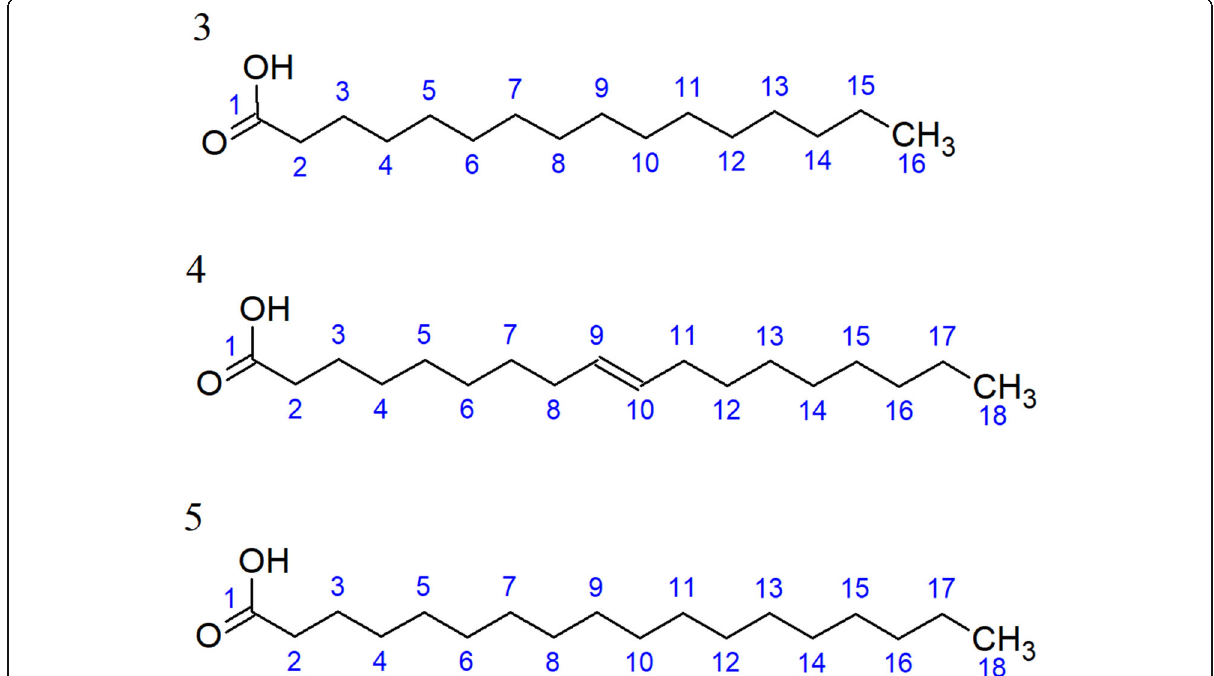
Fig. 5 Structure of hexadecanoic acid/palmitic acid (3), (9Z)-Octadec-9-enoic acid/oleic acid (4) and octadecanoic acid/stearic acid